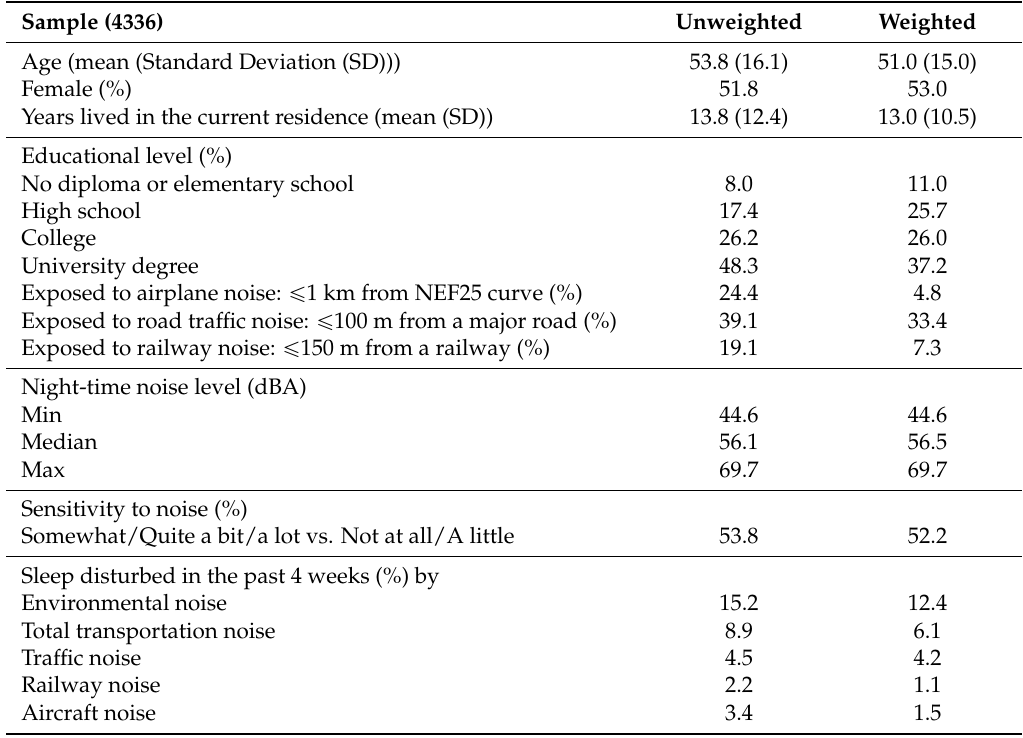
Table 1. Weighed characteristics of the study